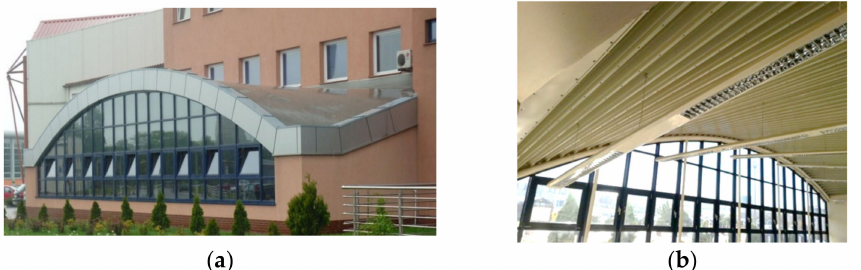
Figure 2. Transformed roof shell with bottom layer composed of folded sheets: ( a ) an outside view; ( b ) an inside view.